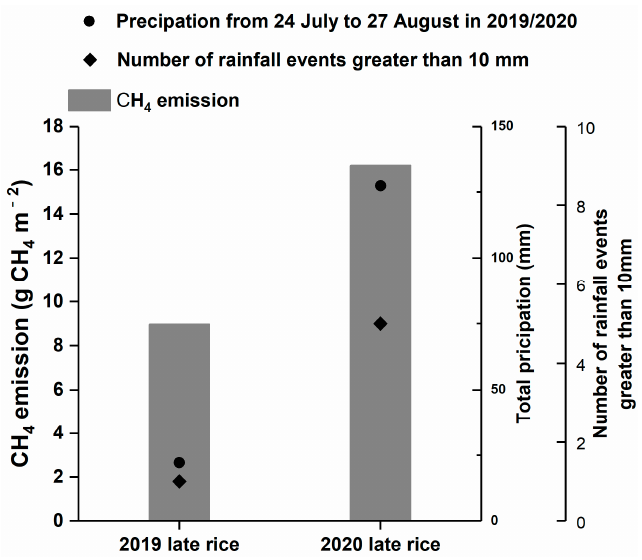
Figure 7. Total CH 4 emissions (black bars), number of rainfall events greater than 10 mm (square dots), and total precipitation (circle dots) from 24 July to 27 August of 2019 and 2020.